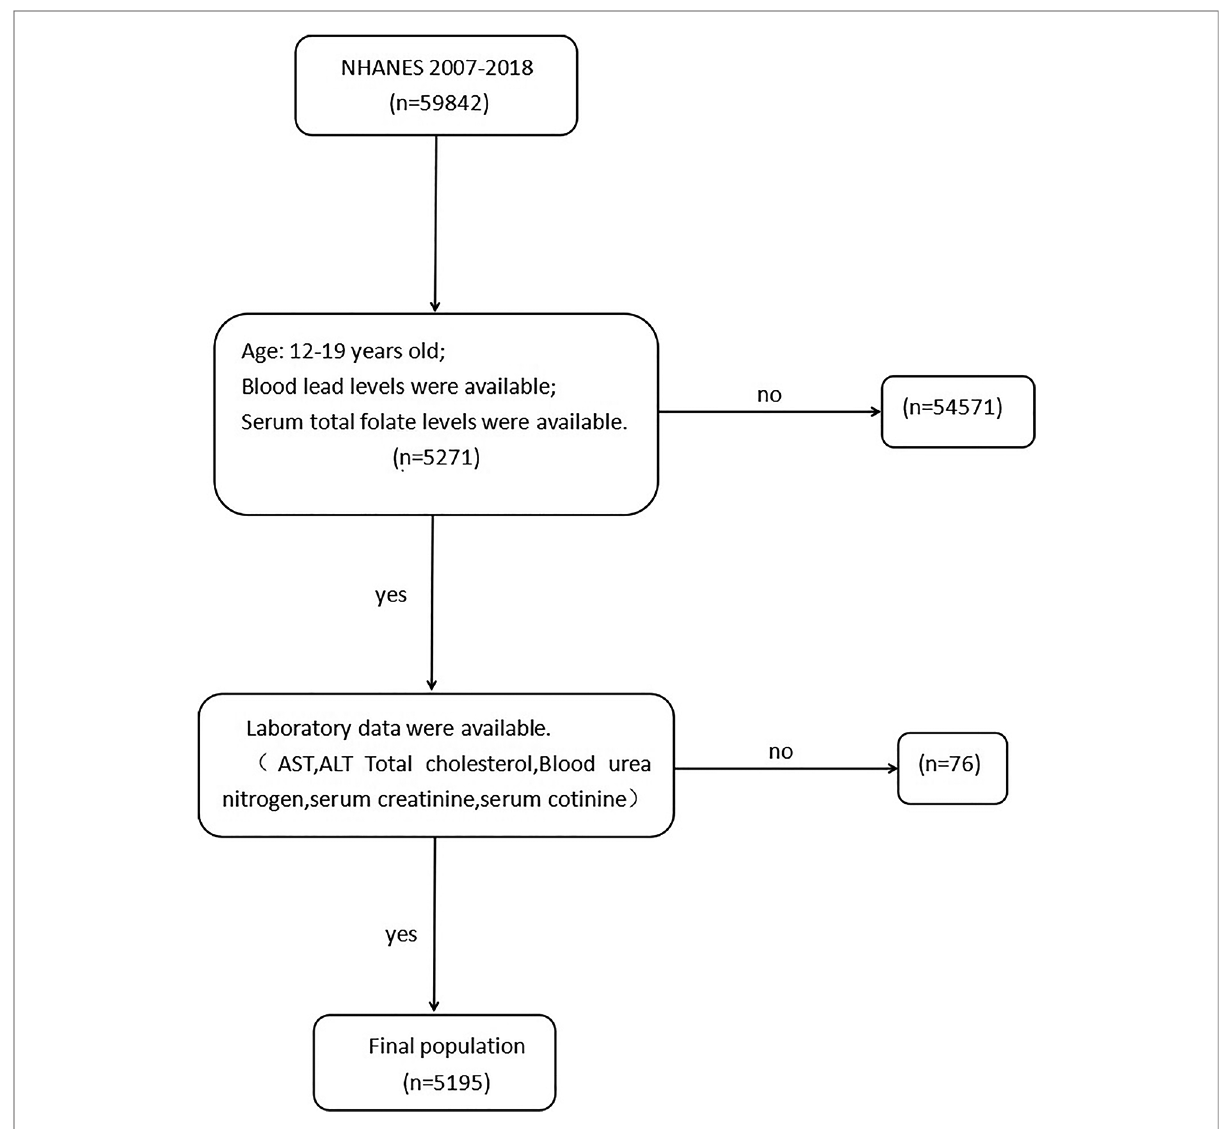
FIGURE 1 Flow chart of participants from NHANES included in the study. AST, aspartate aminotransferase, ALT, alanine